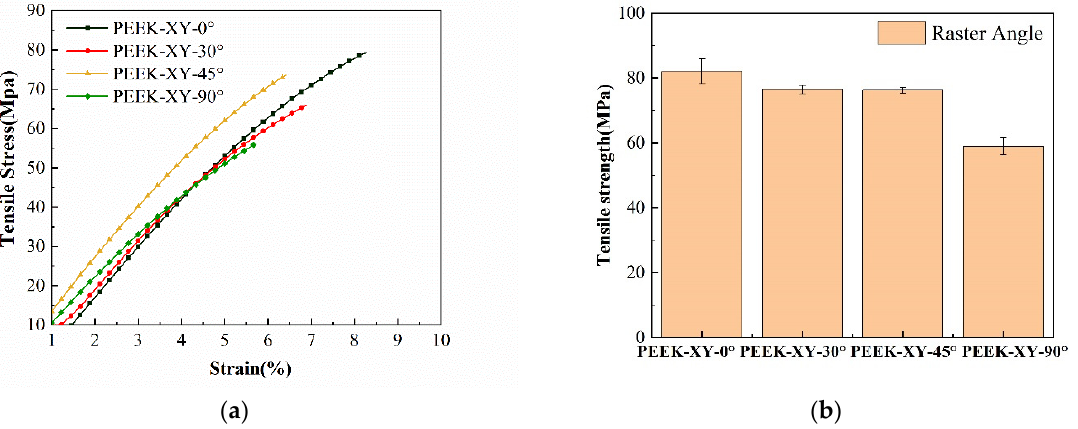
Figure 7. Tensile behaviors with varied raster angles. ( a ) Tensile stress-strain curves; ( b ) average tensile strengths against raster angle.